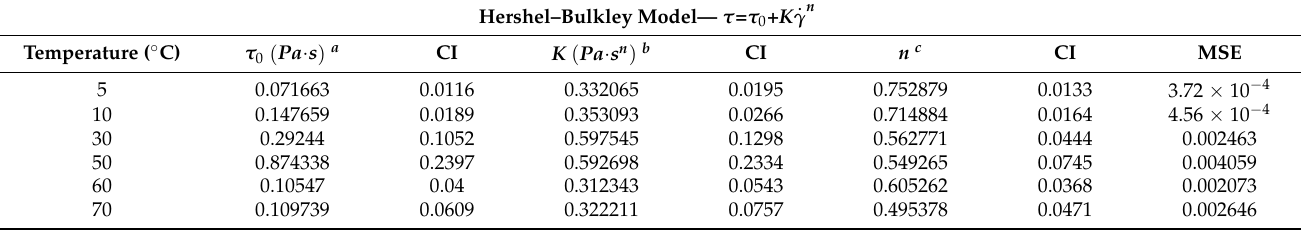
Table A7. Fitting parameters ( τ 0 , K , n ), confidence intervals (CI), and mean square error (MSE) values as a function of temperature obtained from the Hershel–Bulkley model [48] modeling the 0.1 to 1000 s − 1 shear rate range for flow curve data sets of ink suspensions with a 0.80 wt% HRCM load. Hershel–Bulkley Model— τ = τ 0 + K . γ